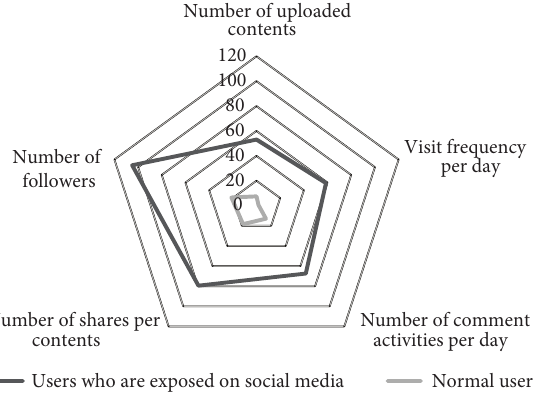
Figure 4. Service use comparison between the users exposed through social media and normal